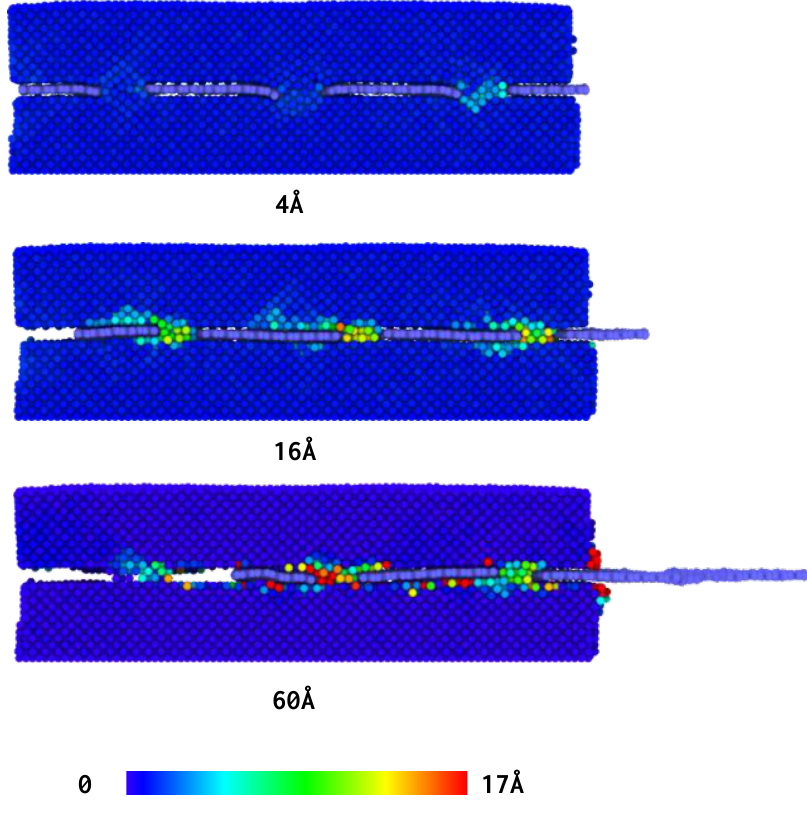
Figure 5. The displacement of copper atoms at the interface of graphene/Cu nanocomposites with various sliding distances.